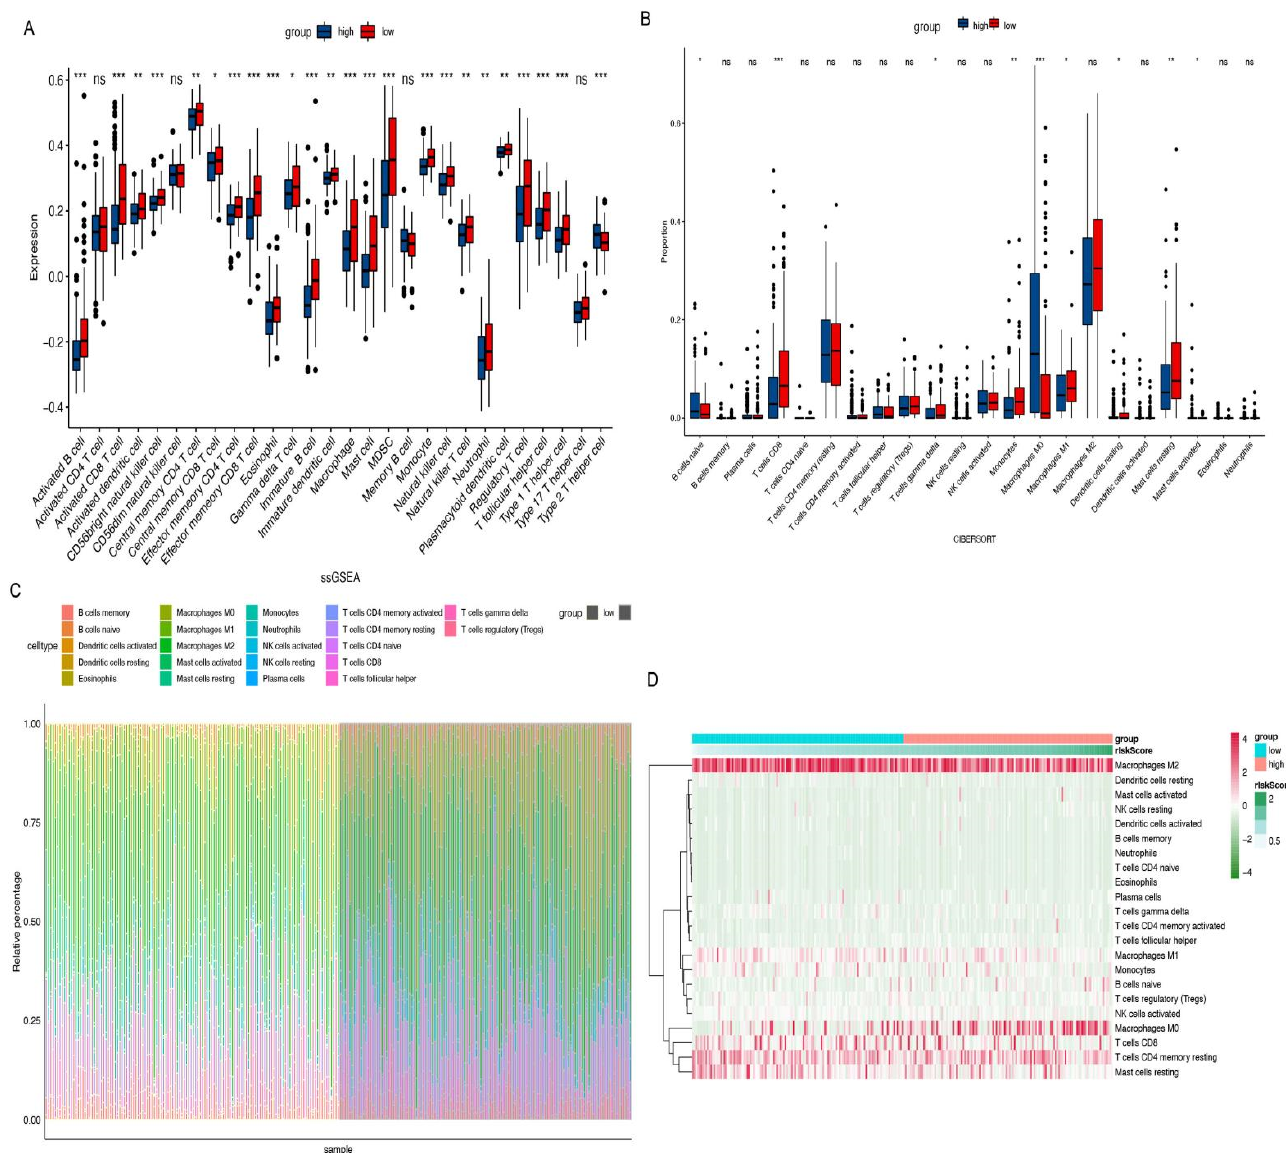
Figure 5. Immune cell populations and TME landscape. ( A , B ) The result of ssGSEA and CIBESORT to demonstrate the difference of immune cell populations between the high- and low-risk groups. ( C , D ) The association and proportions of risk and immune-infiltrations. * p < 0.05. ** p < 0.01. *** p < 0.001. ns: not significant.